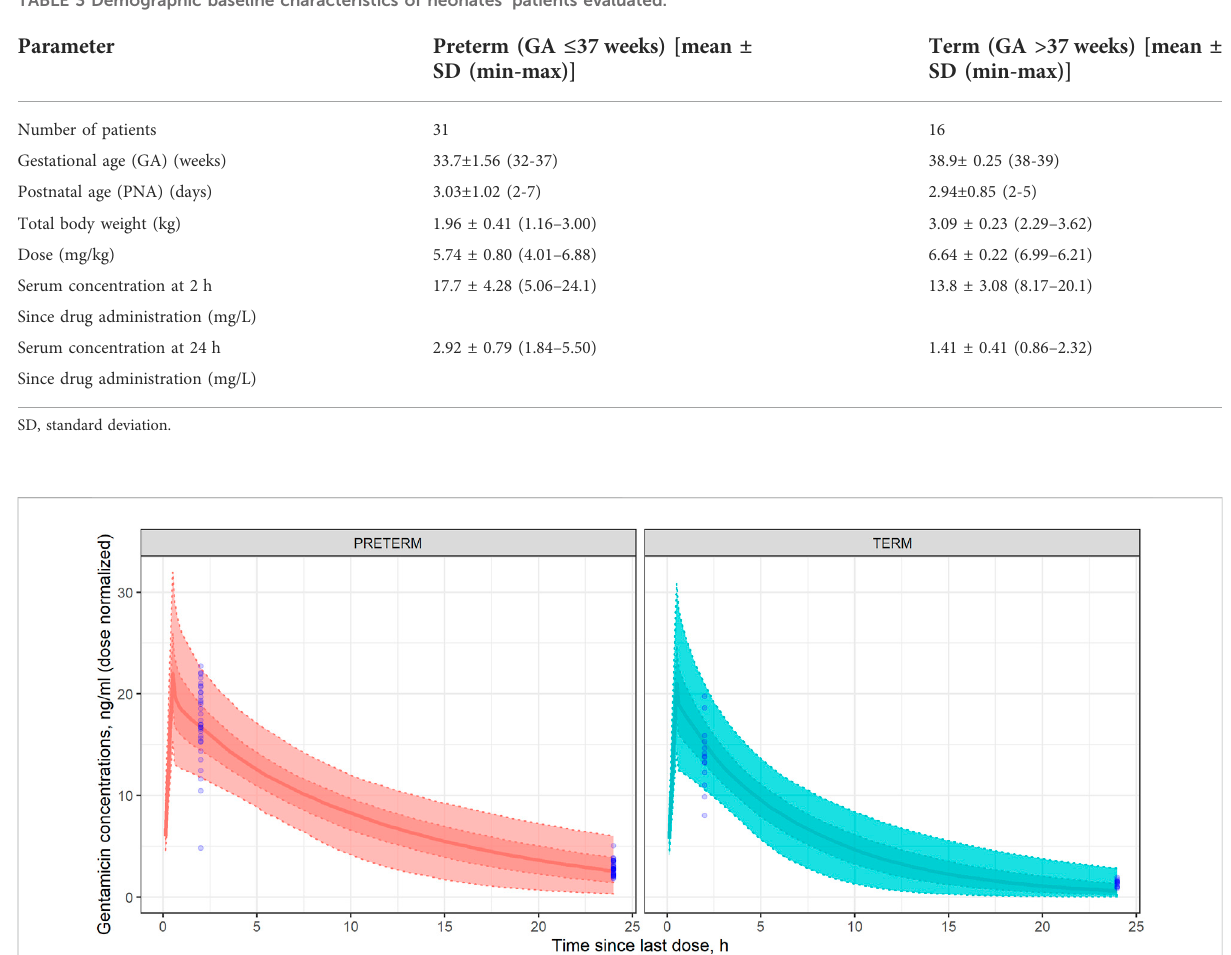
TABLE 3 Demographic baseline characteristics of neonates ’ patients evaluated.